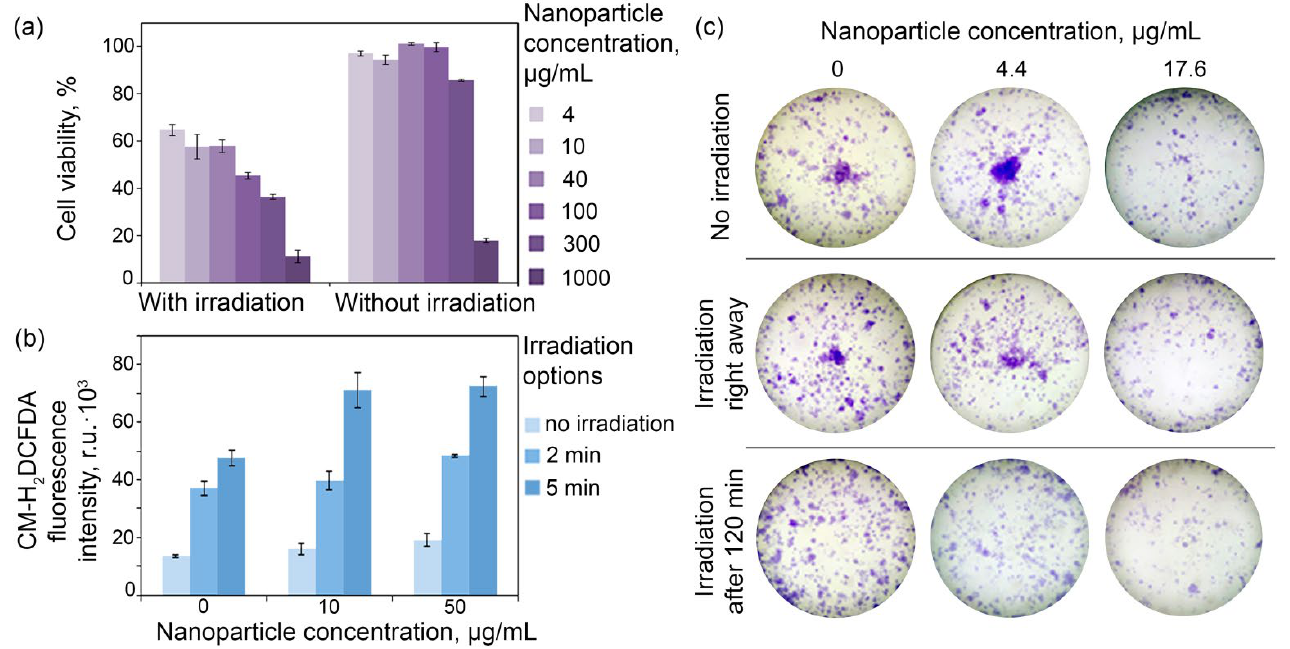
Figure 6. Light-induced cytotoxicity of Ag-PEG-HER2 nanoparticles in vitro. ( a ): Viability of 1ip cells (%) depending on the concentration of targeted silver NPs in the medium ( µ g/mL) (shown in different colors) and the irradiation mode (with/without light) obtained with the MTT test. ( b ): ROS generation upon the blue light irradiation of cells labeled with affibody-decorated Ag NPs: dependence of the fluorescence intensity (r.u.·10 3 ) of cells labeled with ROS indicator on the concentration of nanoparticles and irradiation time. ( c ): Colony formation assay showing the cytotoxic activity of combination affibody-modified Ag-PEG-HER2 particles and irradiation with the blue LED matrix at a power of 95 mW/cm 2 for HER2-positive cells.